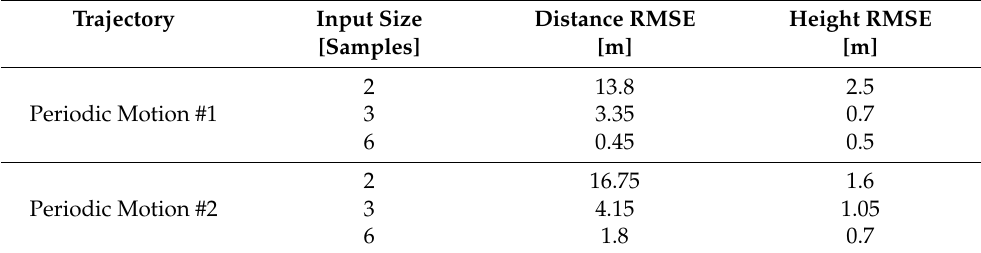
Table 6. Influence of input size on QuadNet1 performance using IMU #1 measurements.